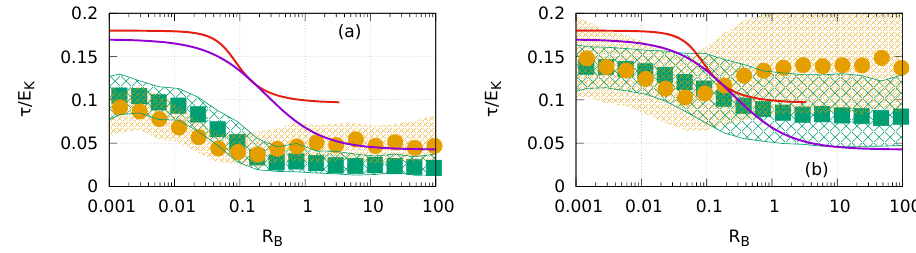
Figure 4. τ / E K as function of R B : ( a ) 30 min averages; and ( b ) 2 min averages. Symbols and colors are the same as in Figure 1a. The red line corresponds to the theoretical behavior from [6], with modified coefficients, the violet one to Mauritsen and Svensson [21].